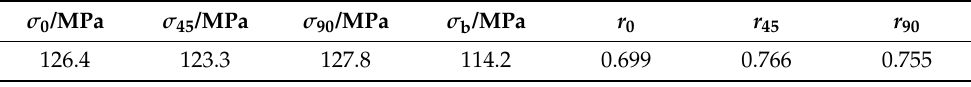
Figure 22. FLD of material TRIP780 based on modified Voce constitutive equation and MMFC